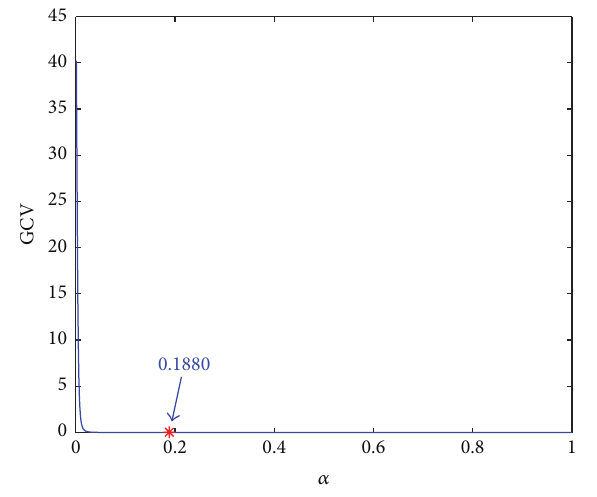
Figure 27: GCV in experiment of MIMO system.